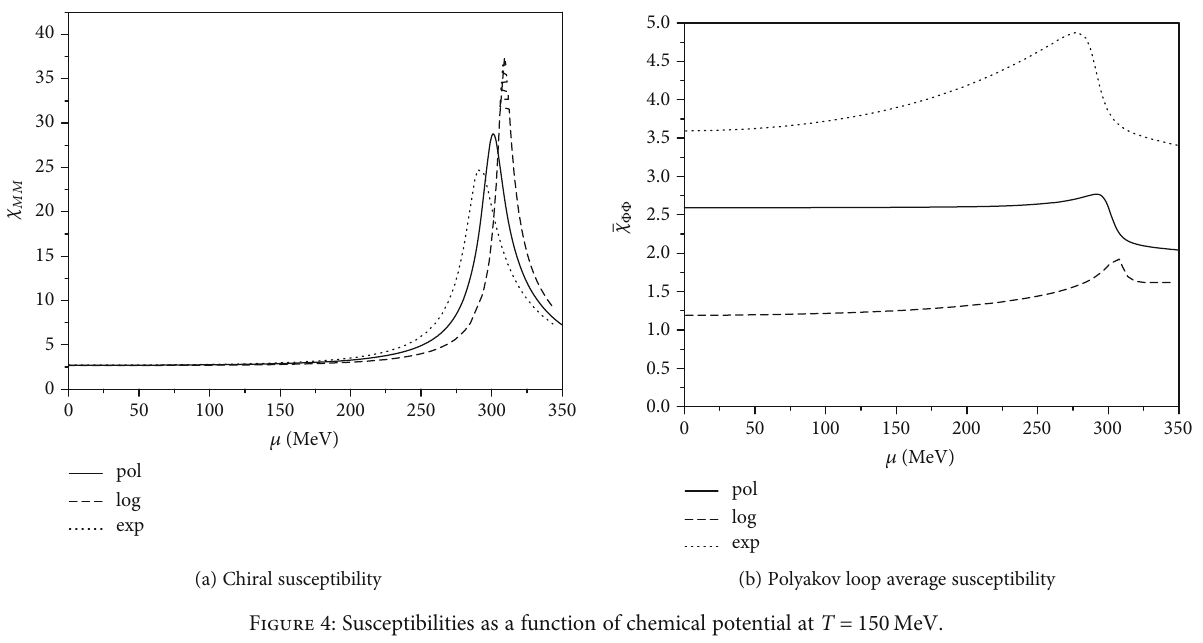
Figure 4: Susceptibilities as a function of chemical potential at T = 150